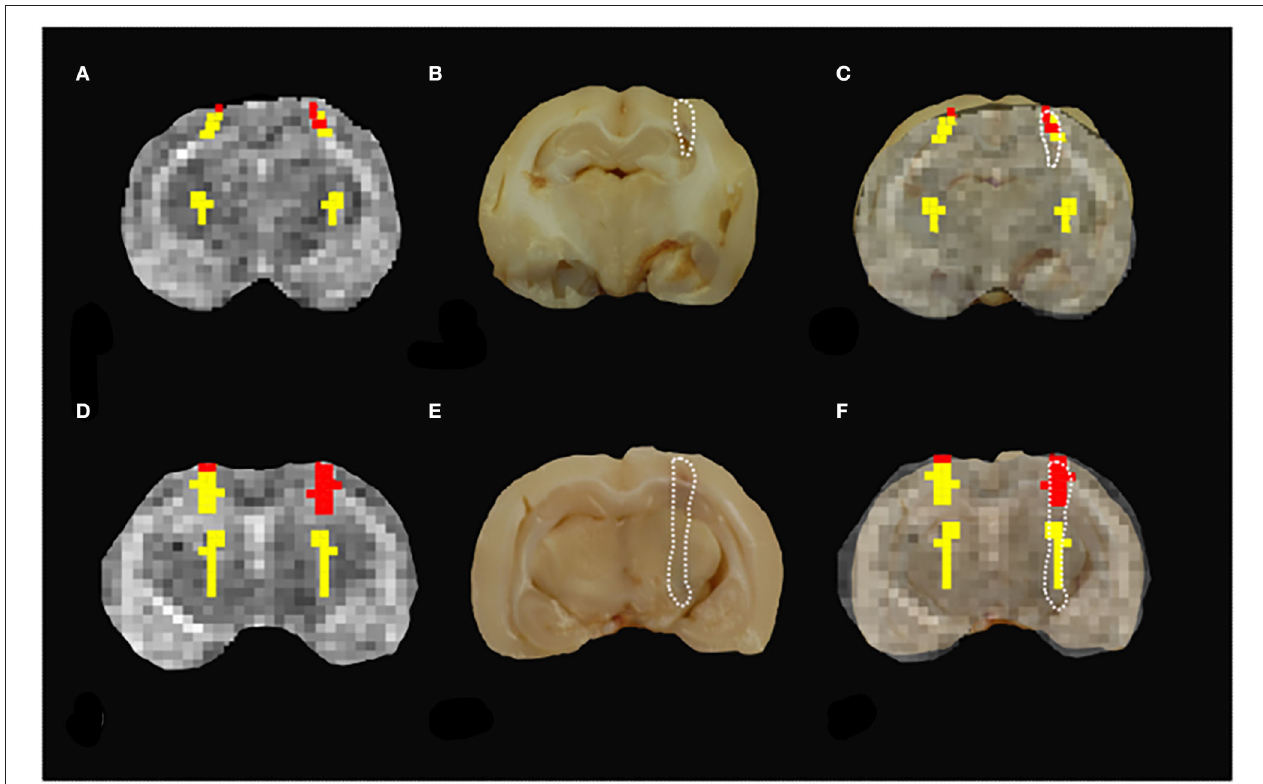
FIGURE 5 | Misclassification results. (A,D) The results of MRR classification do not show a clear distinction between the two groups of pathological vs. healthy parenchyma since pathological tissue was found in the healthy hemisphere. (B,E) The hemorrhagic lesion contour (white dashed line) is estimated from the gross anatomy. (C,F) The comparison between the MRR classification and the true lesion contour shows that in these two cases the performance of the classifier is poor since both healthy (yellow) and pathological (red) voxels fall inside the lesion